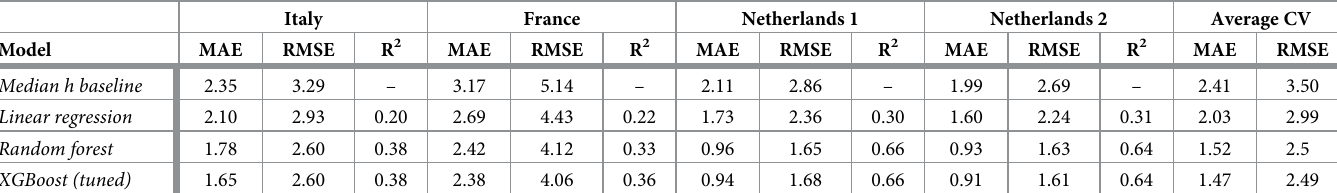
Table 3. Model comparison